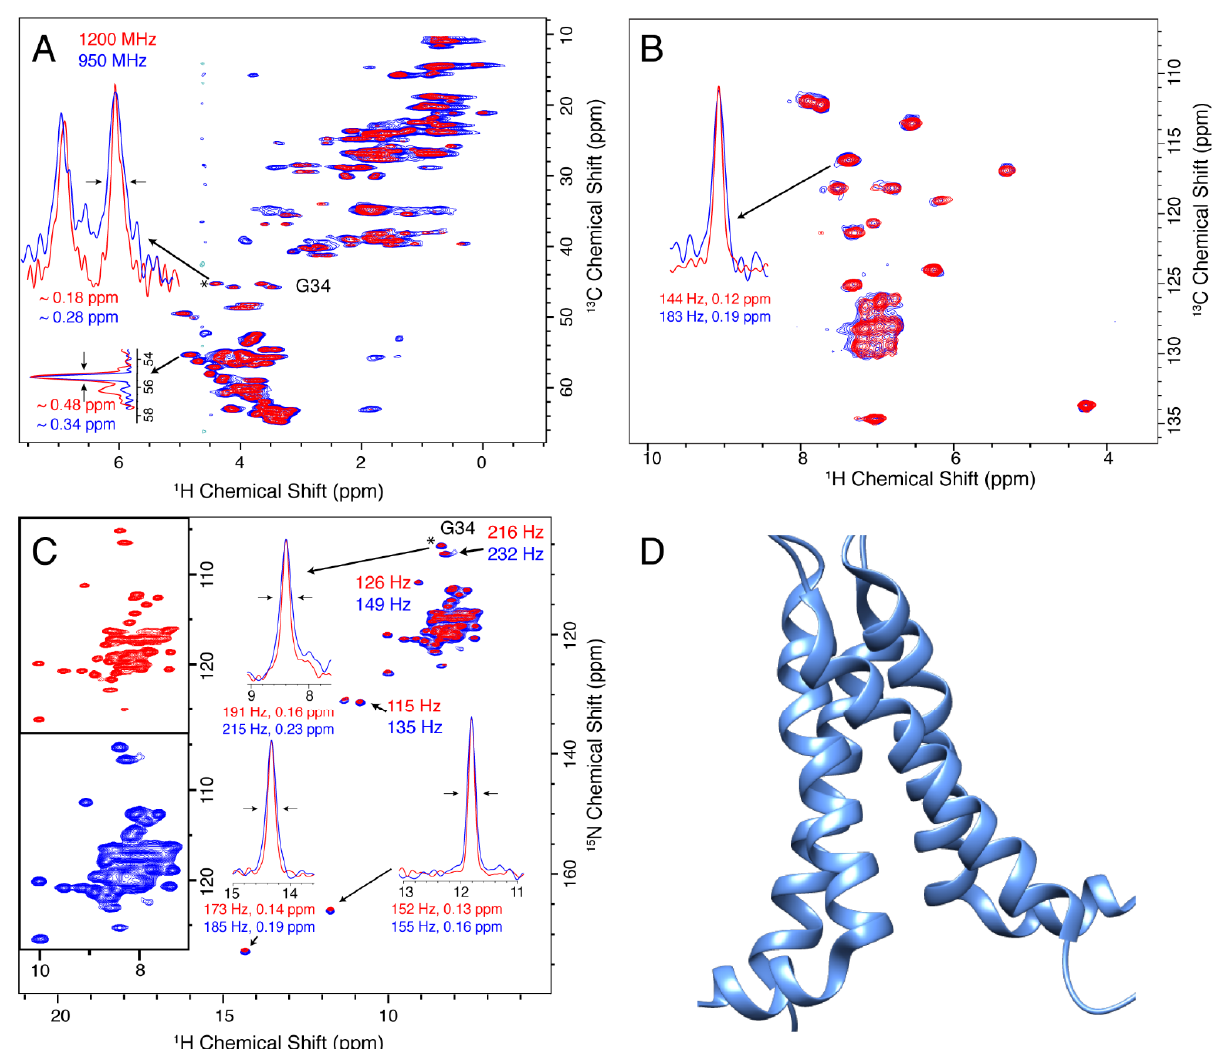
Figure 1. Spectra of fully protonated Influenza A M2 recorded at 950 (blue) and 1200 (red) MHz spectrometers using 100 kHz MAS. Panel ( A ) shows the CP based C-H spectrum, (H)CH, and the slice shows linewidths of G34 α protons. In ( B ), the aromatic region of the same spectrum is shown. Panel ( C ) shows the CP-based N-H spectrum and linewidths of selected peaks. The insets show the linewidths of selected peaks that are resolved in the 2D spectrum. The peak indicated with a (*) was used to set the base contour level to a consistent fraction of the peak intensity for each set of overlaid spectra. In ( D ), the tetrameric structure of M2 is shown, taking the coordinates from protein data bank (PDB) code 2N70, which contains the S31N substitution, but shows a similar ‘dimer-of-dimers’ spectrum as the wild type sequence for which the spectra were recorded.